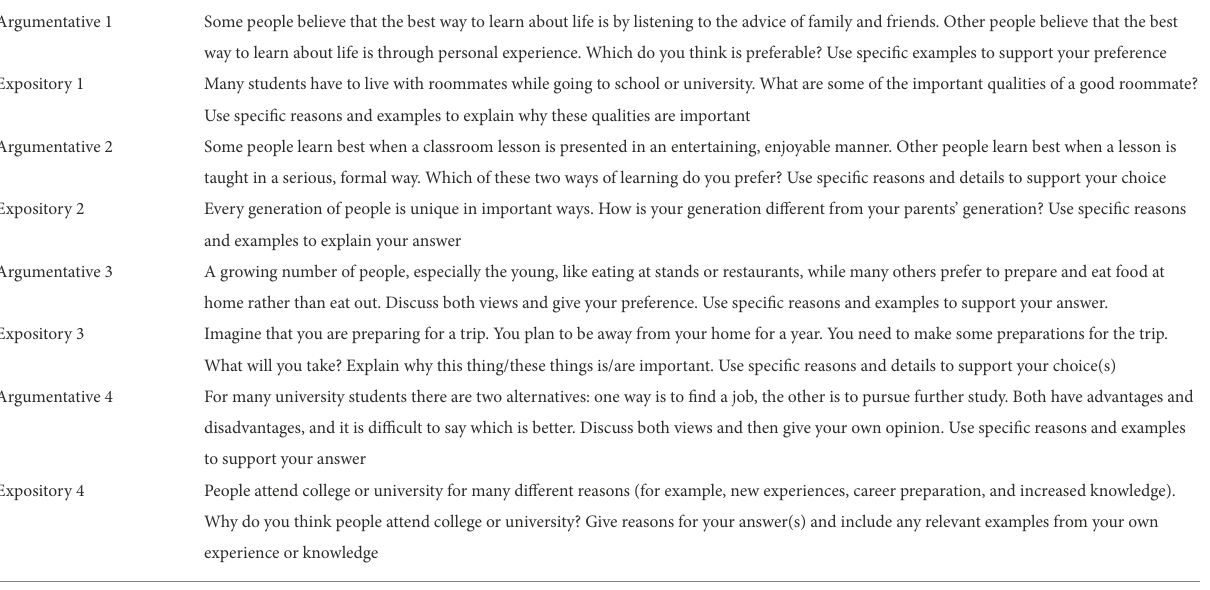
TABLE 2 The writing prompts for the argumentative and expository